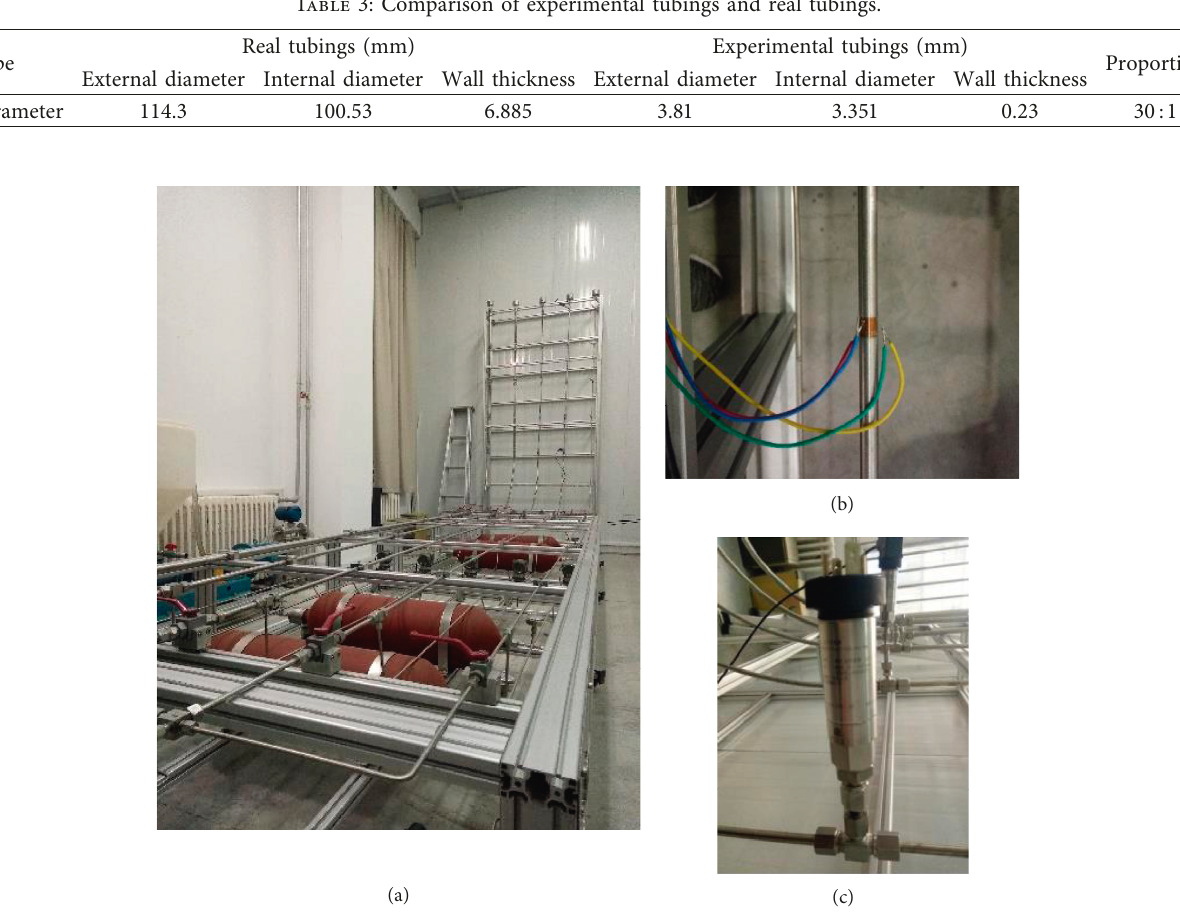
Figure 9: Hardware experimental device for simulation of injection and production in UGS.